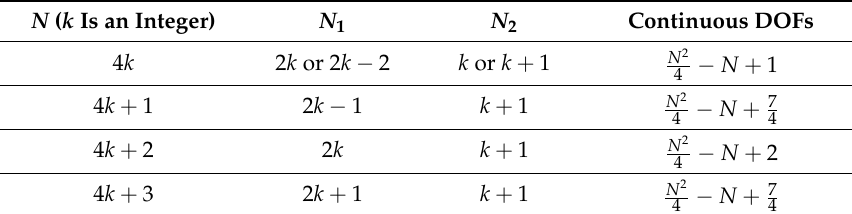
Table 1. The relationship between N , N 1 , N 2 and DOFs of TPNAs-I. N ( k Is an Integer)